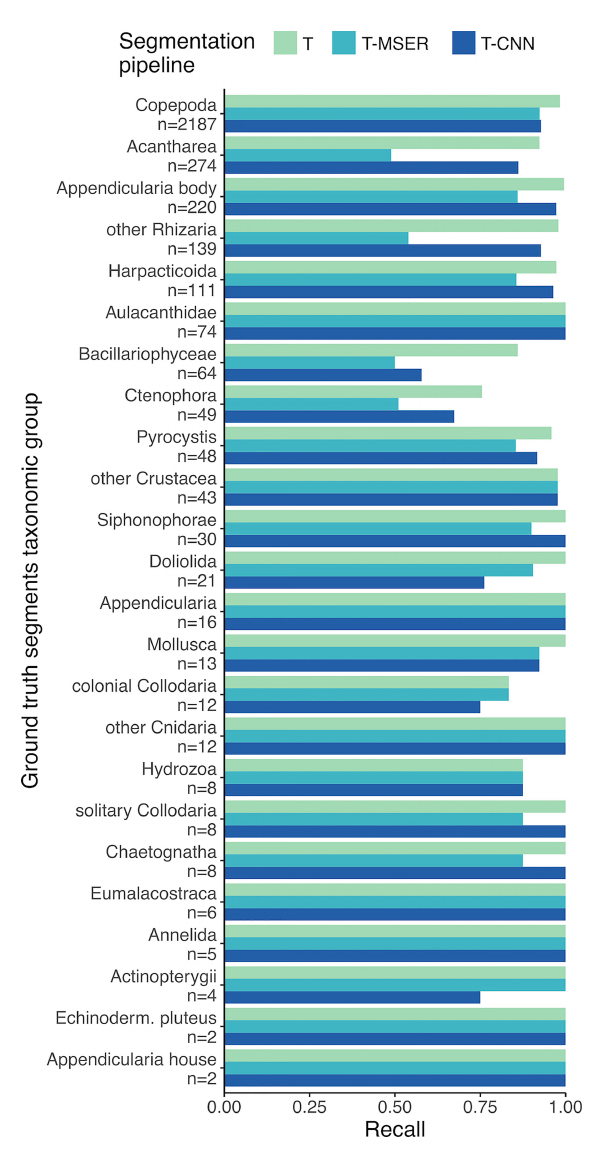
FIGURE 6 | Recall scores per taxon. n is the number of individuals from each taxon in the 106 benchmark images and taxa are sorted in decreasing order of abundance. T, threshold-based; T-MSER, threshold-MSER; T-CNN,